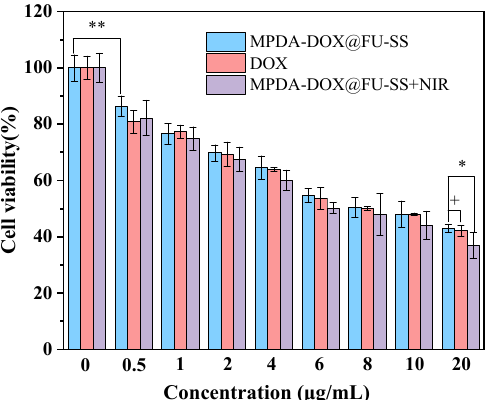
Figure 8. HCT-116 cell viability rate after 24 h of treatment with MPDA-DOX@FU-SS, DOX, and MPDA-DOX@FU-SS+NIR (n = 3; ** p < 0.01, * 0.05 > p > 0.01, + p > 0.05).